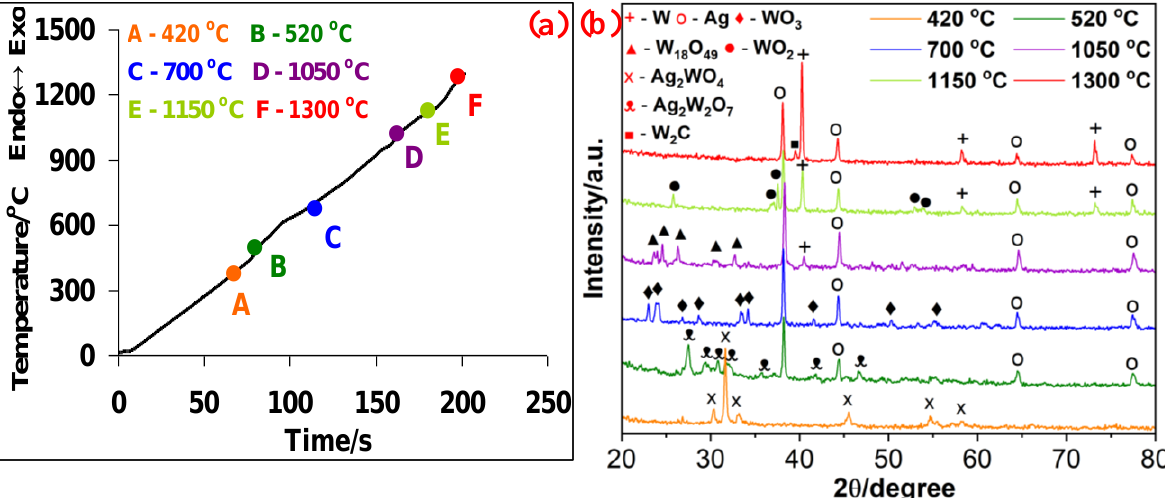
Figure 5. Heating curve of the Ag 2 WO 4 + 3C mixture, β = 300 °C min −1 ( a ) and XRD analysis results of the quenched samples ( b ).